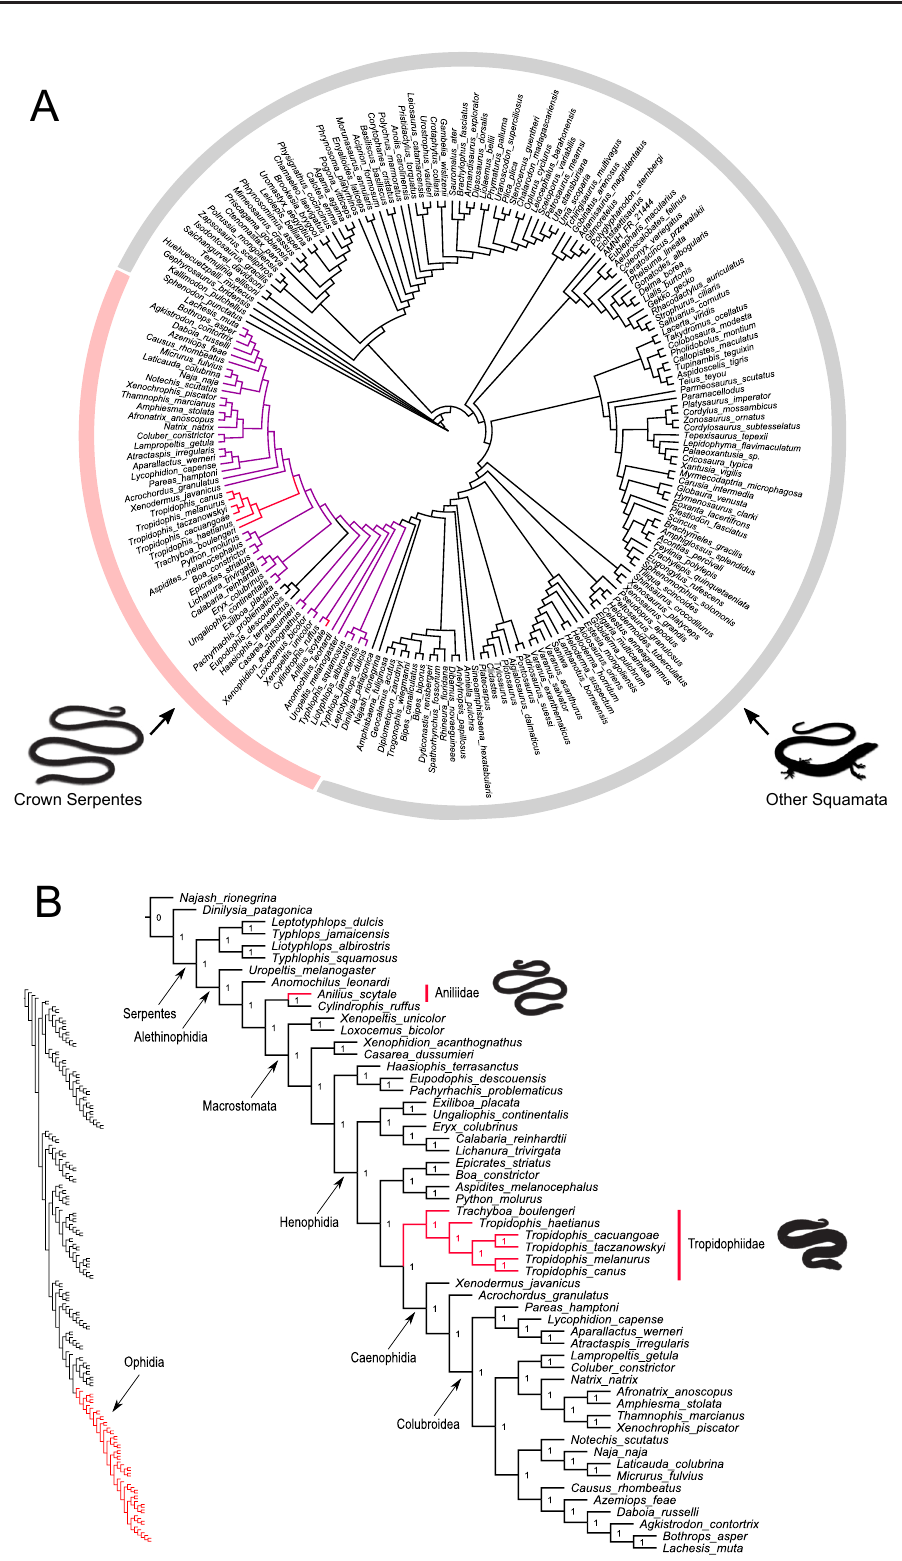
Fig. 3. Morphological phylogeny of Squamata, inferred under Maximum Parsimony. A . Overview of full topology (Amerophidia, red; Extant Serpentes, purple; Other Squamates, black). B . Ophidia topology (Amerophidia, red; node support is Bremer